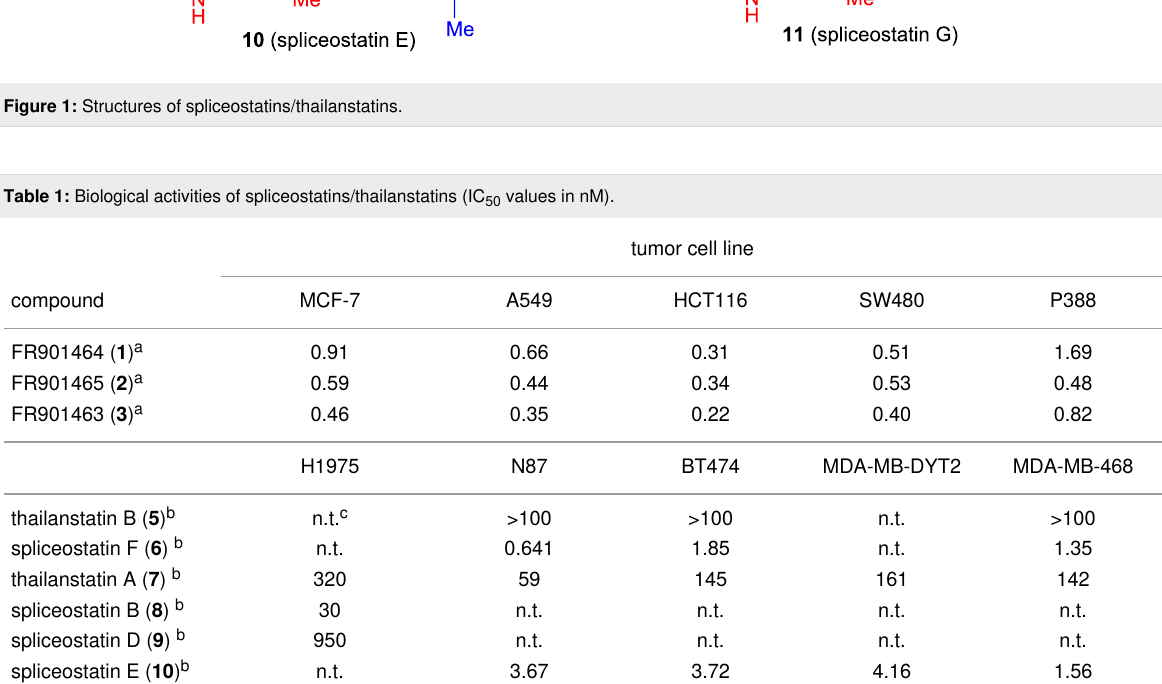
Figure 1: Structures of spliceostatins/thailanstatins.